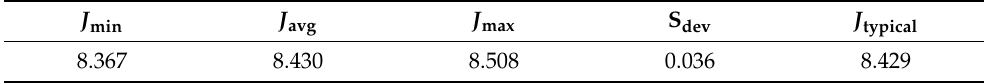
Table 11. Statistics regarding the optimum criterion ( SENSOR mode =